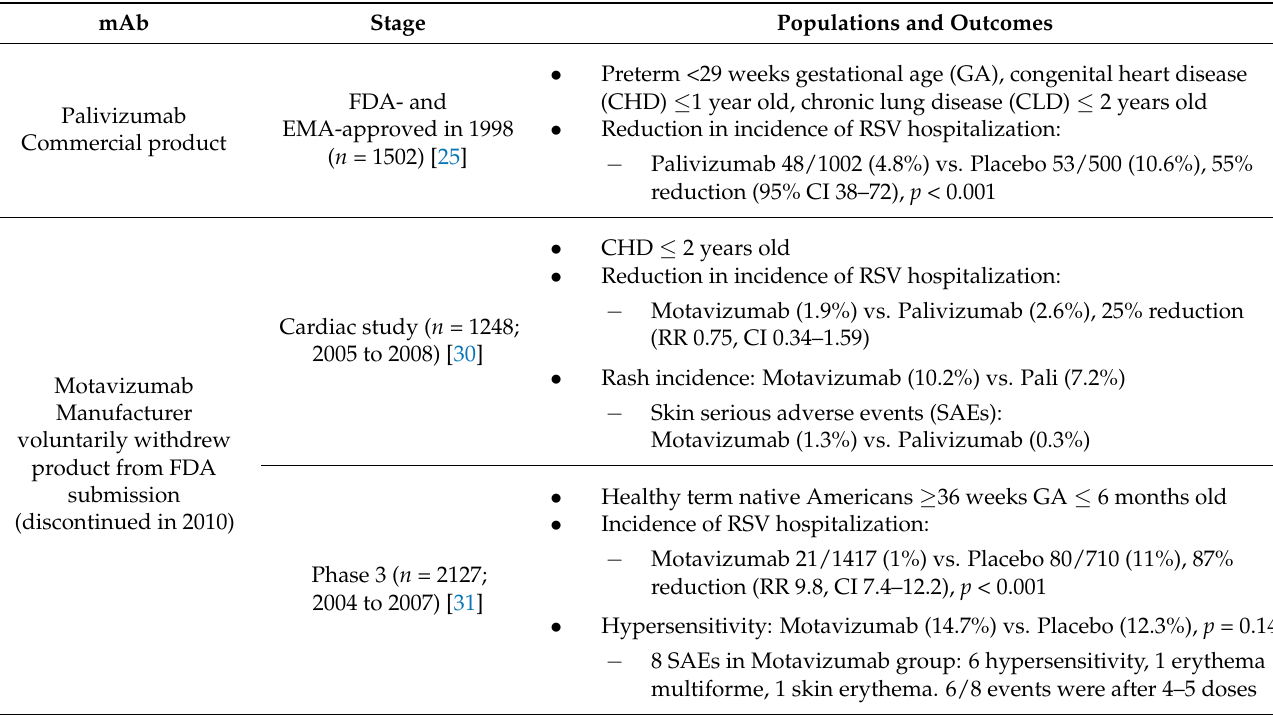
Table 1. Completed and ongoing phase 2 and 3 trials of RSV